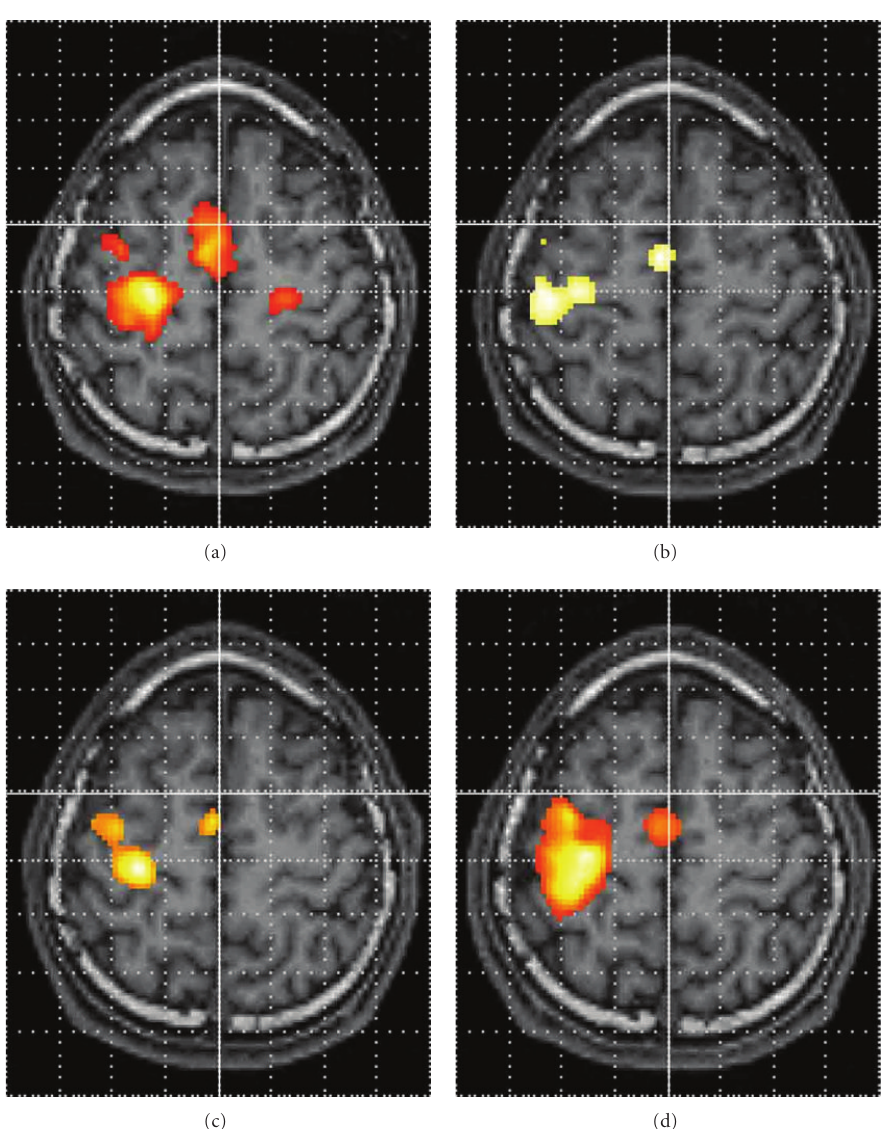
Figure 5: Serial fMRI results of a 18-year-old male right BPI patient with good recovery. (a) The first fMRI (before operation), (b) the second fMRI (approximately 1 year after operation), (c) the third fMRI (approximately 2 years after operation), and (d) the fourth fMRI (approximately 3 years after operation). The patients’ right is on the observers’